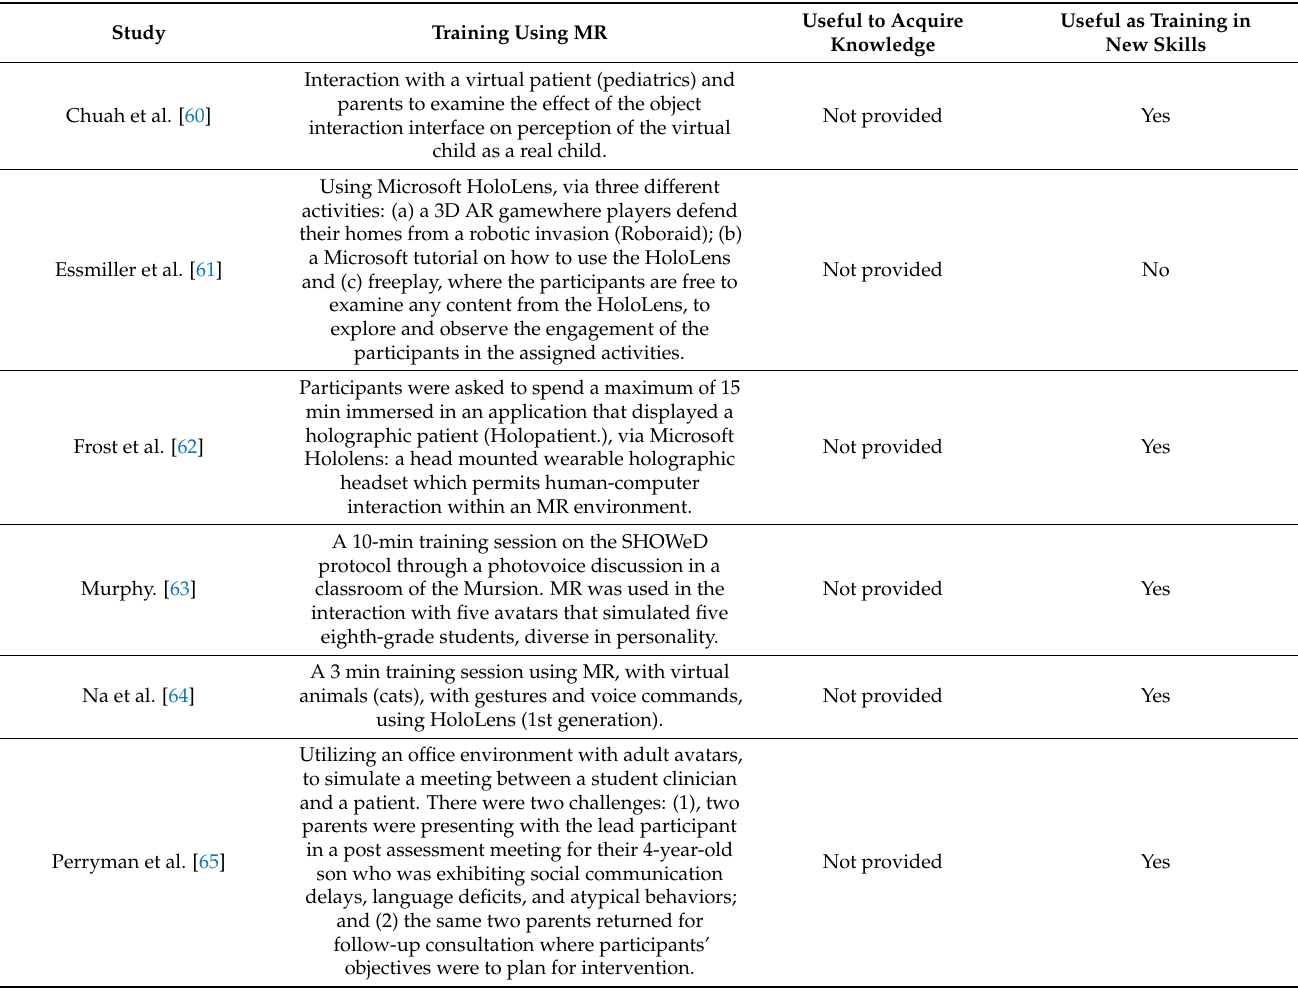
Table 3. Primary outcomes (n =